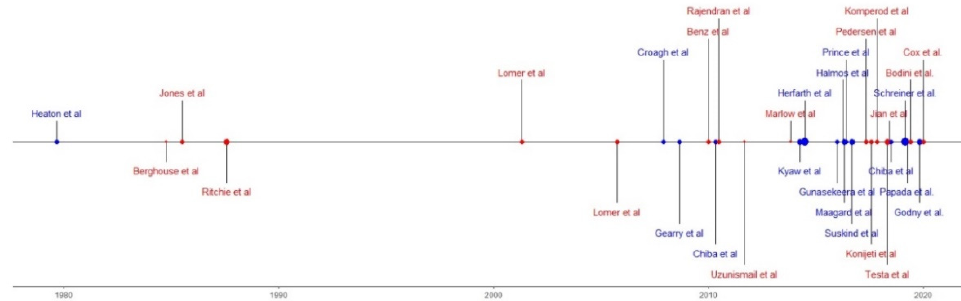
Figure 2. Chronological review according to type of study and sample size: red points, clinical trials; blue points, observational Studies.